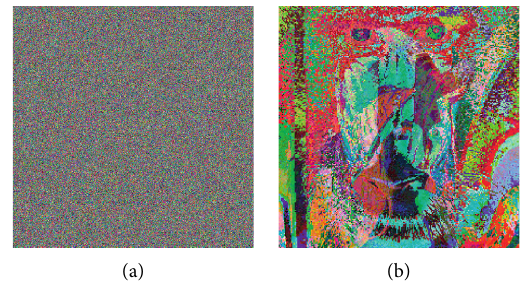
Figure 14: The result of chosen plaintext attack analysis: (a) E 1 ⊕ E 2; (b) O 1 ⊕ O 2.